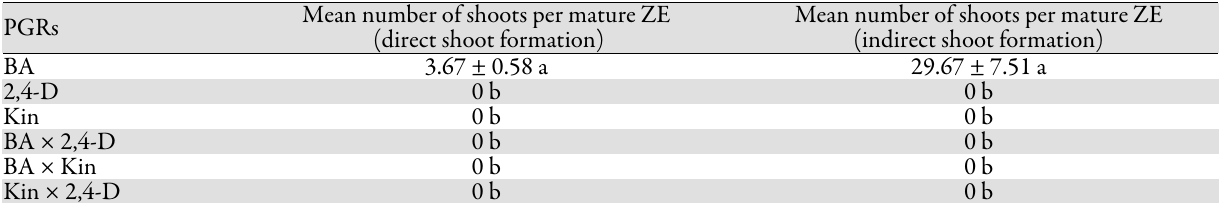
Table 1. Effect of plant growth regulators (PGRs), all at 0.5 mg l -1 , in ½ MS medium on shoot induction of Cycas revoluta zygotic embryos after 35 days in